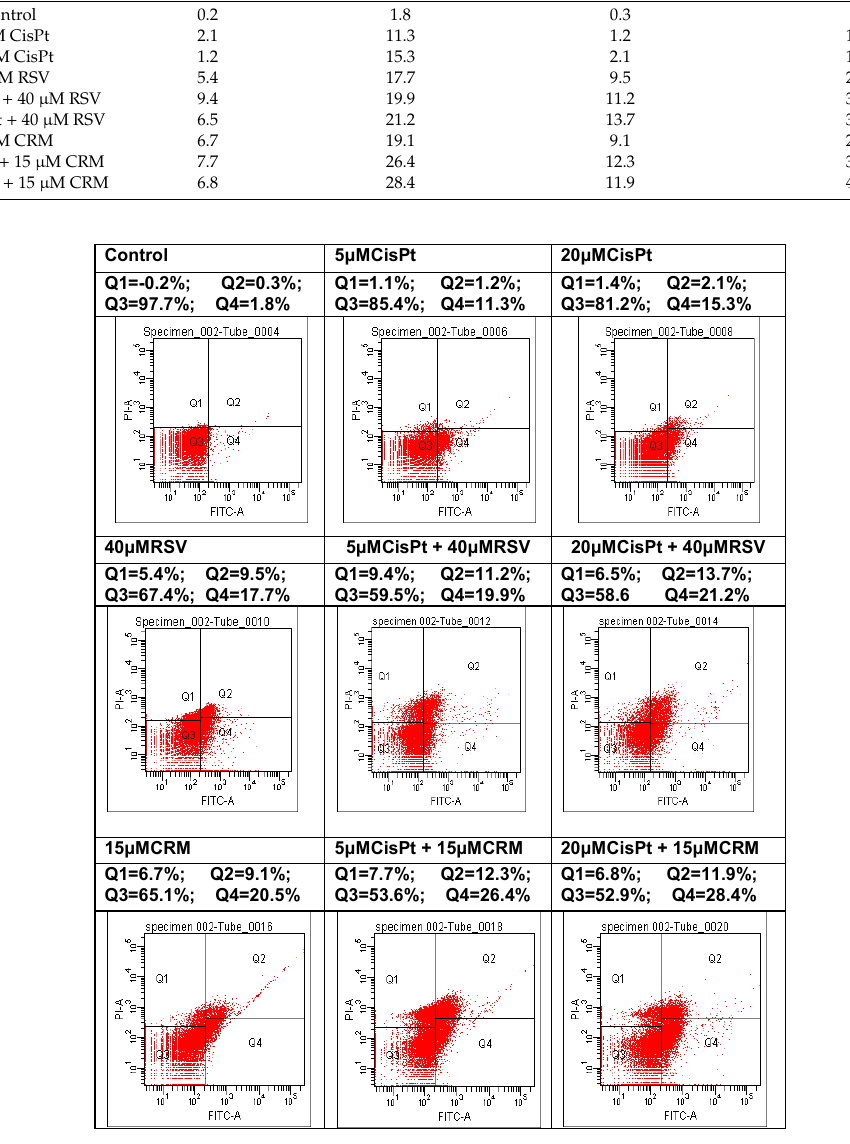
Table 6. Apoptosis of PE / CA-PJ49 tumor cells induced by 24 h treatment with CisPt and / or RSV, CRM. Treatment